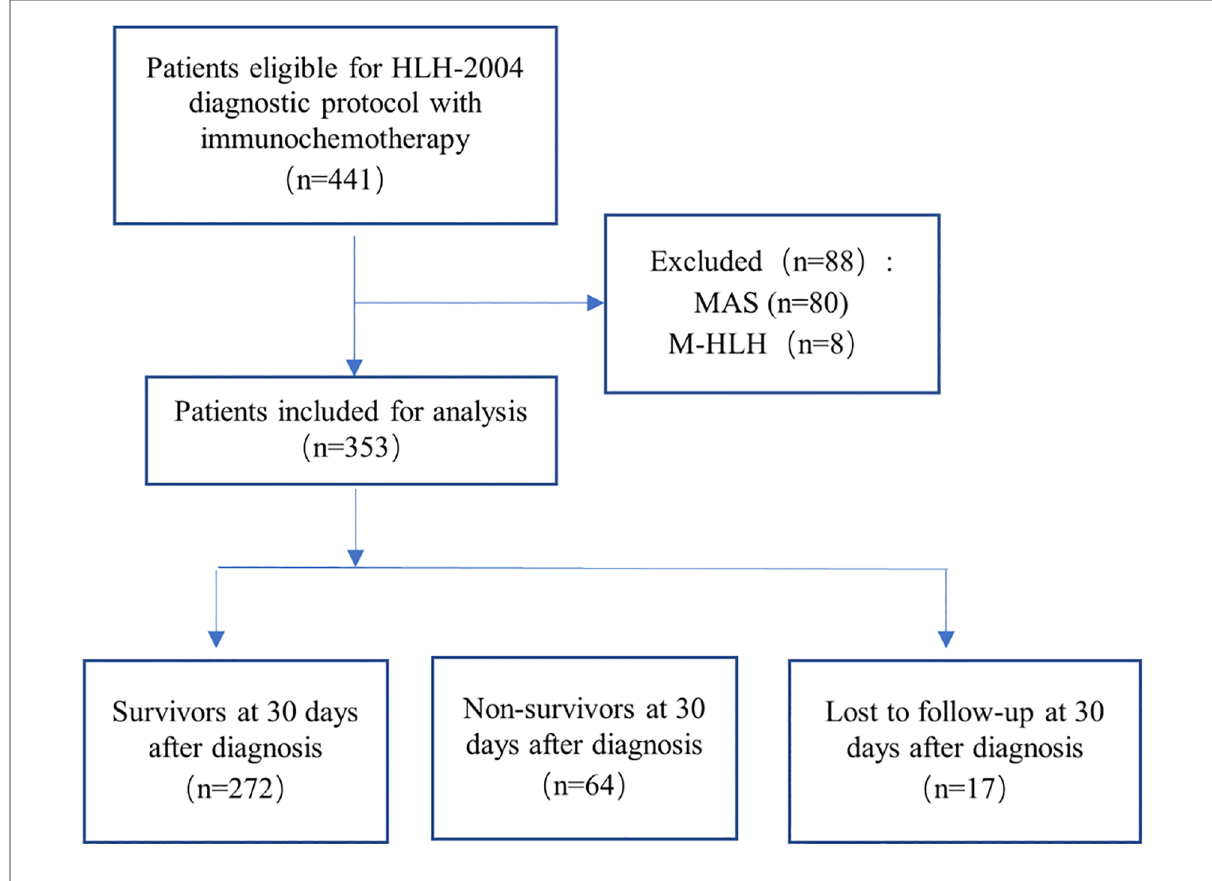
FIGURE 1 Flowchart of inclusion and exclusion. Abbreviations: MAS, macrophage activation syndrome; M-HLH, malignancy-associated